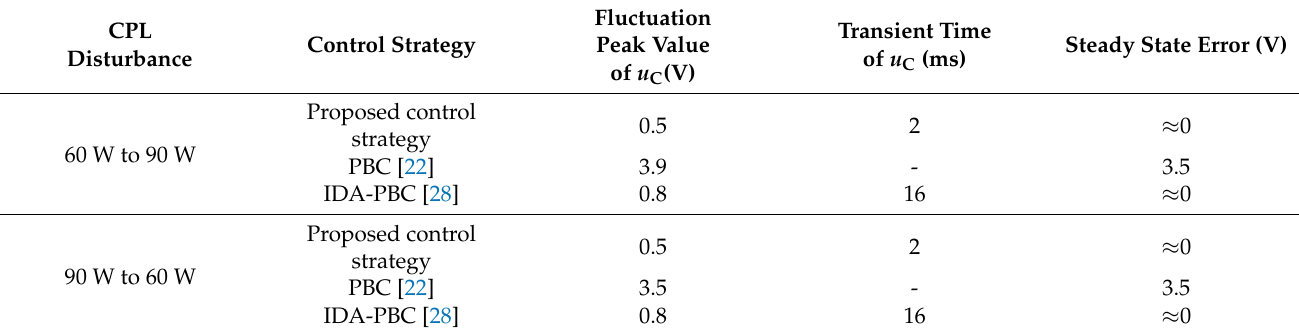
Table 3. Simulation results for u C of DDBC under different control strategies and CPL disturbances. CPL